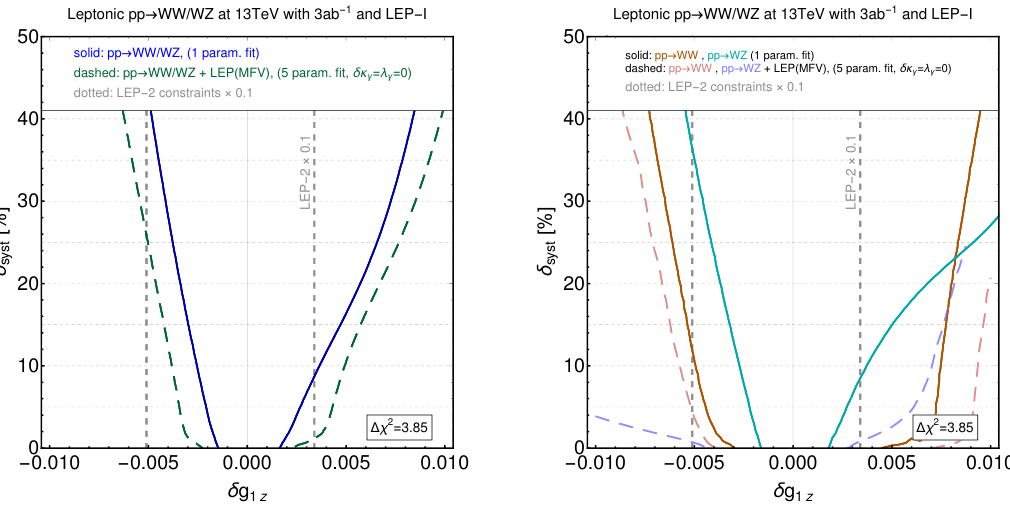
Figure 7 . Estimated 95% CL bounds on the aTGC at HL-LHC. Solid and dashed stand for (cid:14) syst = 5% and (cid:14) syst = 30% respectively. The bounds on (cid:14)(cid:20) (cid:13) , (cid:14)g 1 z change by a factor two to three between the 3-parameter and the 7-parameter (cid:12)ts, while the bound on (cid:21) (cid:13) remains una(cid:11)ected. The aTGC bounds in 3-parameter (cid:12)t agrees well with the ones obtained for universal theories, see (cid:12)gure 17.